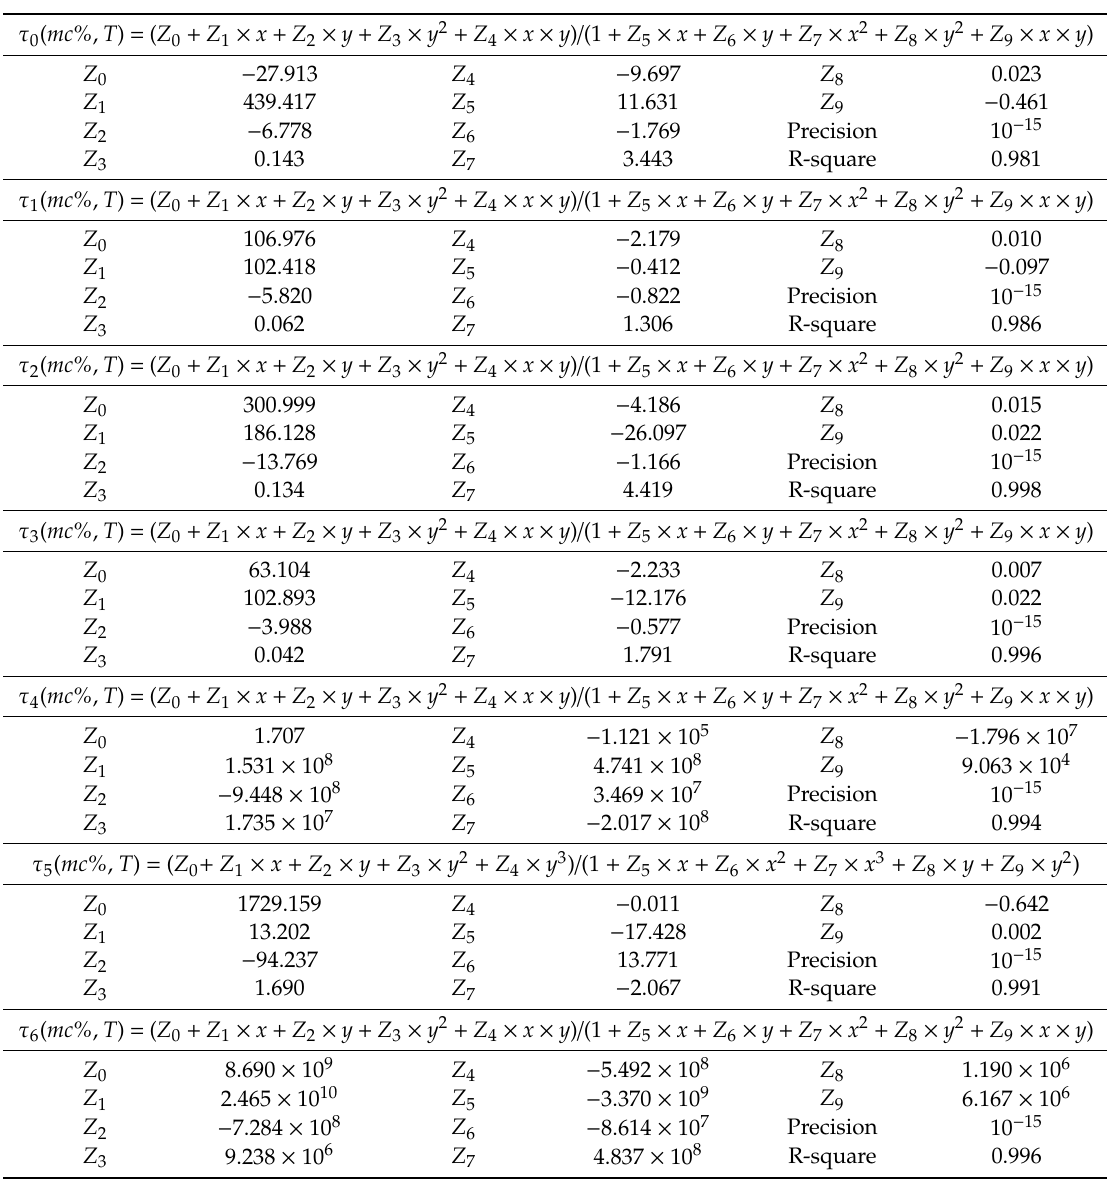
Table 6. Function model for calculating the normalized parameters τ j ( mc %, T